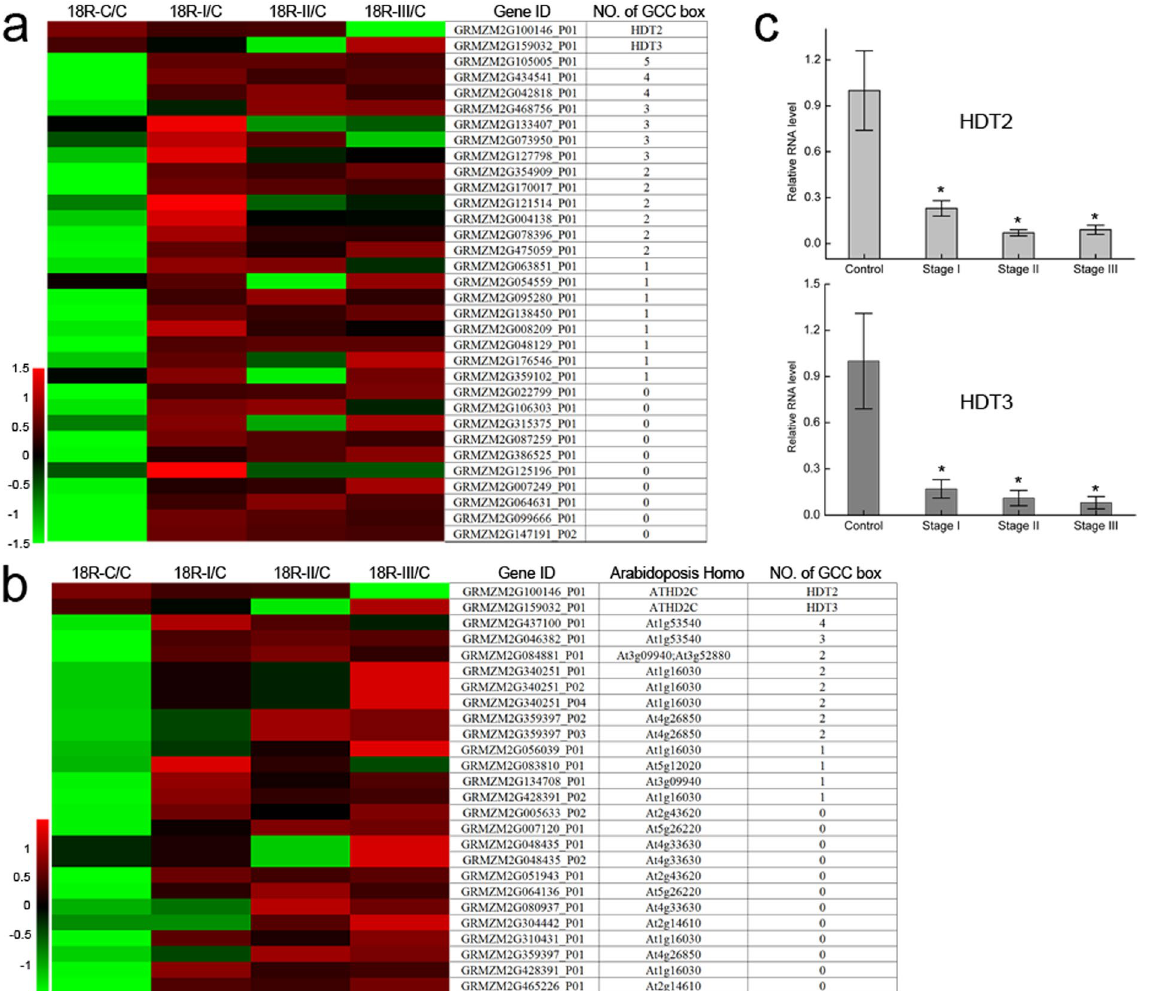
Figure 8. Expression pattern of genes potentially regulated by histone deacetylase. ( a ) Heatmap of proteins in the 18R blue module that show a significantly negative correlation with HDT2 (GRMZM2G100146) and HDT3 (GRMZM2G159032). No. of GCC box is the number of “GCCGCC” sequences in the promoter (3000 bp upstream of ATG). The “GCC box” was reported to be bound by ERF to regulate gene expression. ERF can directly interact with histone deacetylases to further function. ( b ) Heatmap of transcription changes of potential downstream genes of ERF and histone deacetylase at the 3 stages of 18R. ( c ) Relative expression level of HDT2 and HDT3 are shown as means ± SD (n = 3) during callus formation of 18R. * P < 0.05 (Student’s t test) for differences between control and each